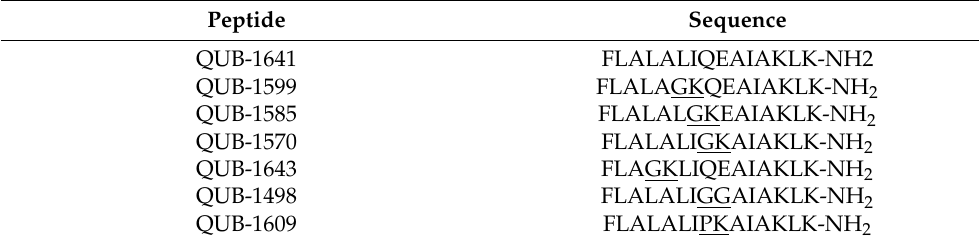
Figure 5. The amino acid sequences of 120 temporins were recorded in Seq2logo. The amino acid diversity at each position is sorted in descending order. Table 1. The sequences of QUB-1641 and its